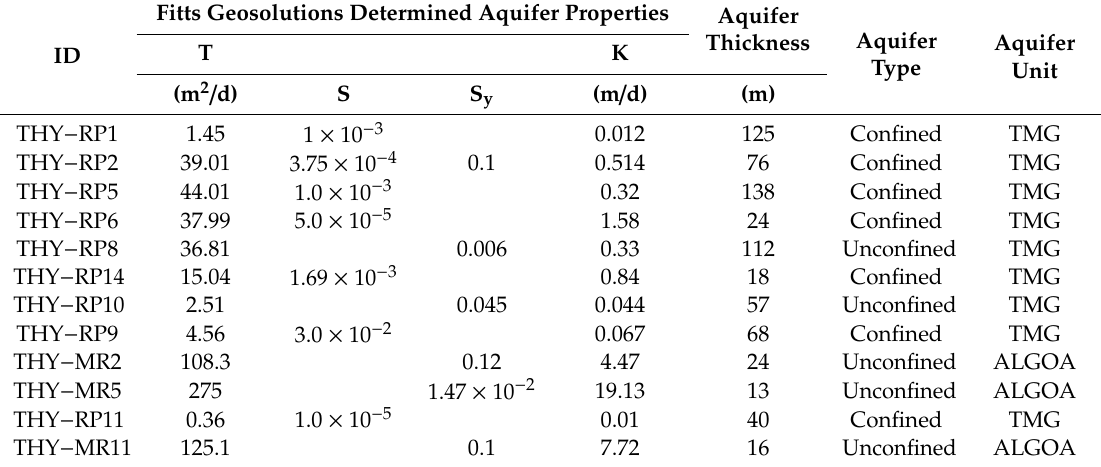
Table 1. Hydraulic properties of aquifers estimated from pumping test data analyses of 11 boreholes (T: Transmissivity, S: Storativity, Sy: Specific yield, K: Hydraulic conductivity). Pumping test data provided by